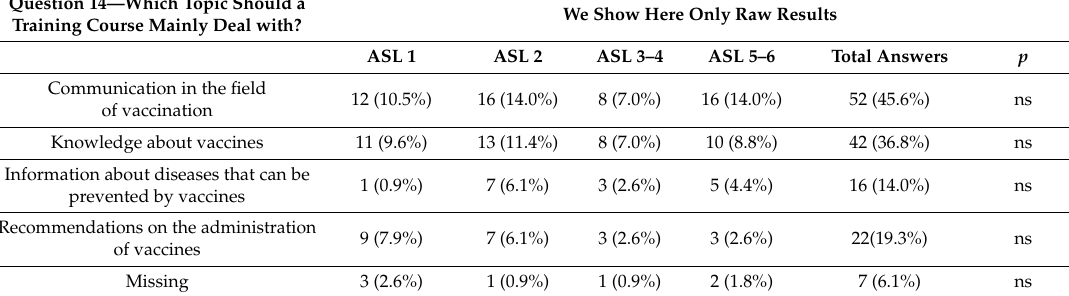
Table 5. Questions about course